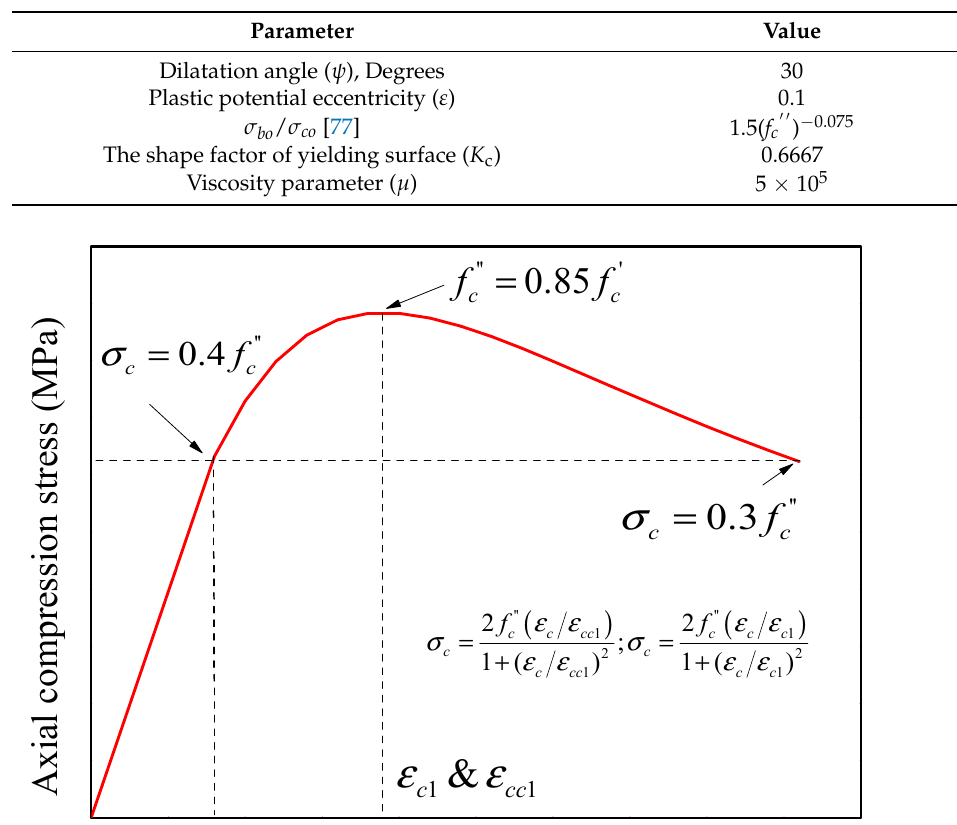
metric ratio of GFRP spirals.